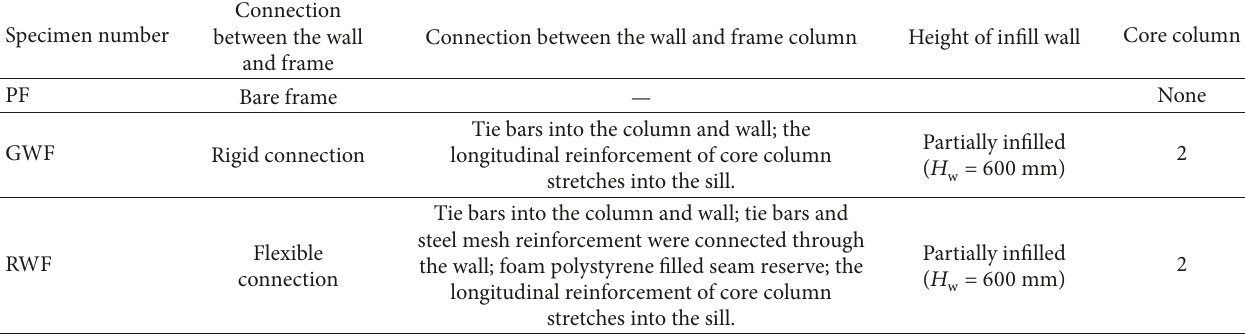
Table 1: Description of